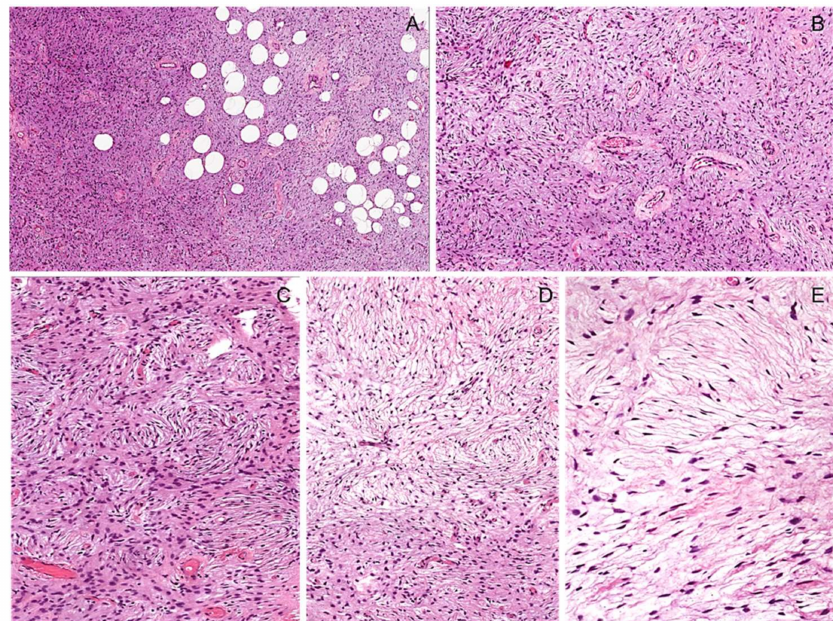
Figure 18. Soft tissue perineurioma. ( A ) Low-magnification image showing a moderately cellular bland-looking spindle cell tumor with focal infiltrative margins into the subcutaneous adipose tissue. ( B ) Perivascular hyalinization is seen. ( C ) Bland-looking spindle cells arranged in a storiform/whorled or reticular ( D ) growth pattern and set in a fibro-myxoid stroma. ( E ) High-magnification image showing bland-looking slender fibroblast-like cells with long bipolar cytoplasmic processes.